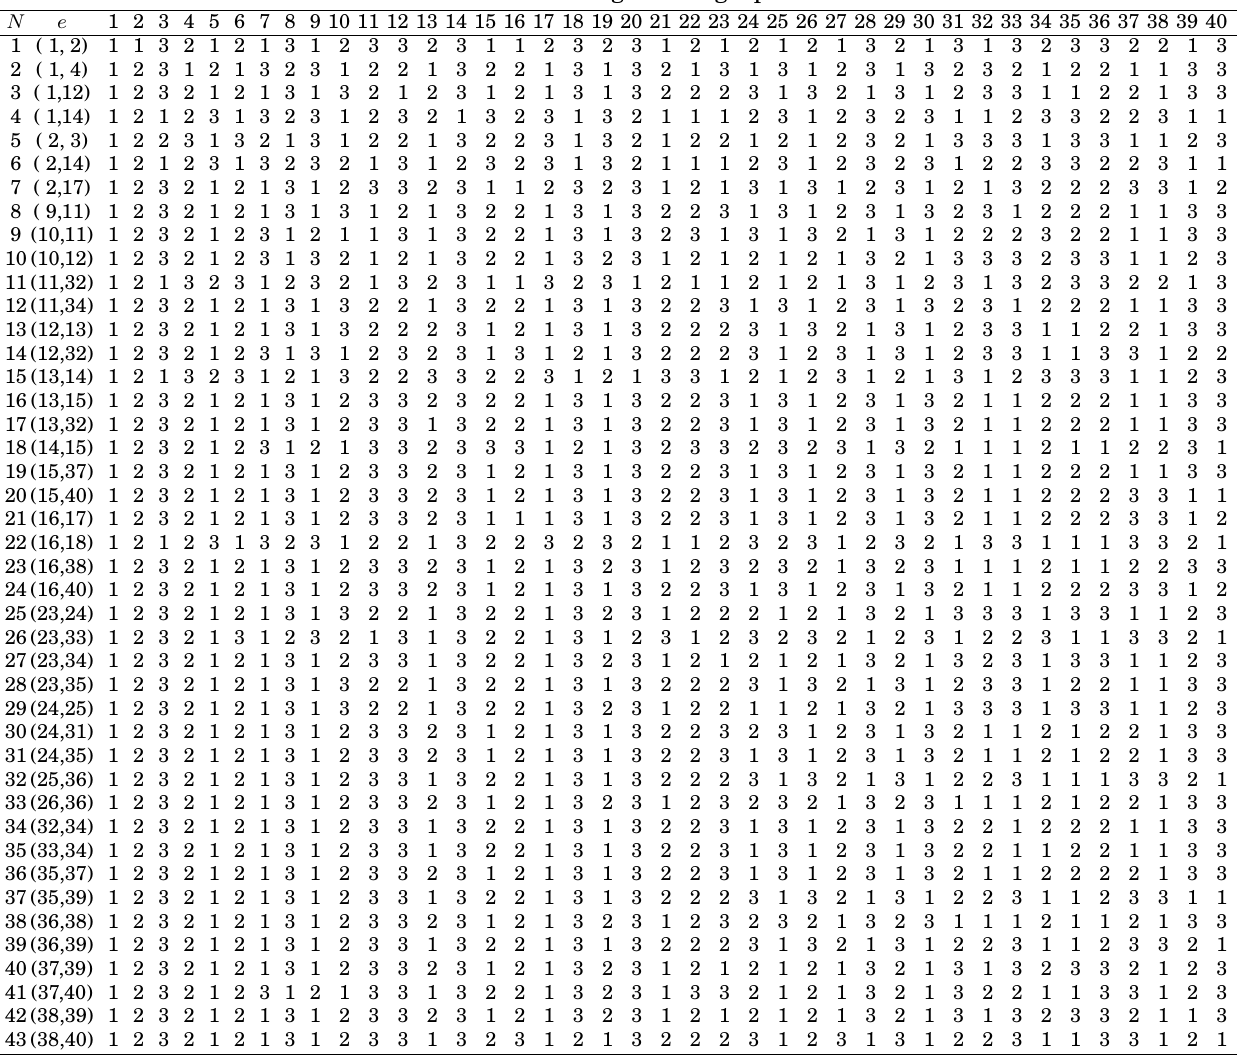
Table 1: The 3-colorings of the graph K 2 − e